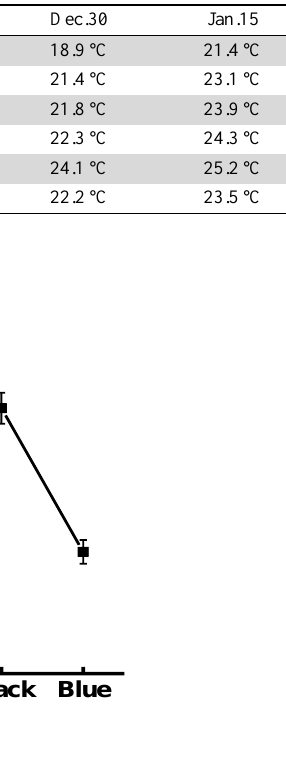
Fig. 1. Effects of different types of plastic films on soil pH. Line graph represents a mean value of three independent experiments and the vertical bars indicate SE (n =